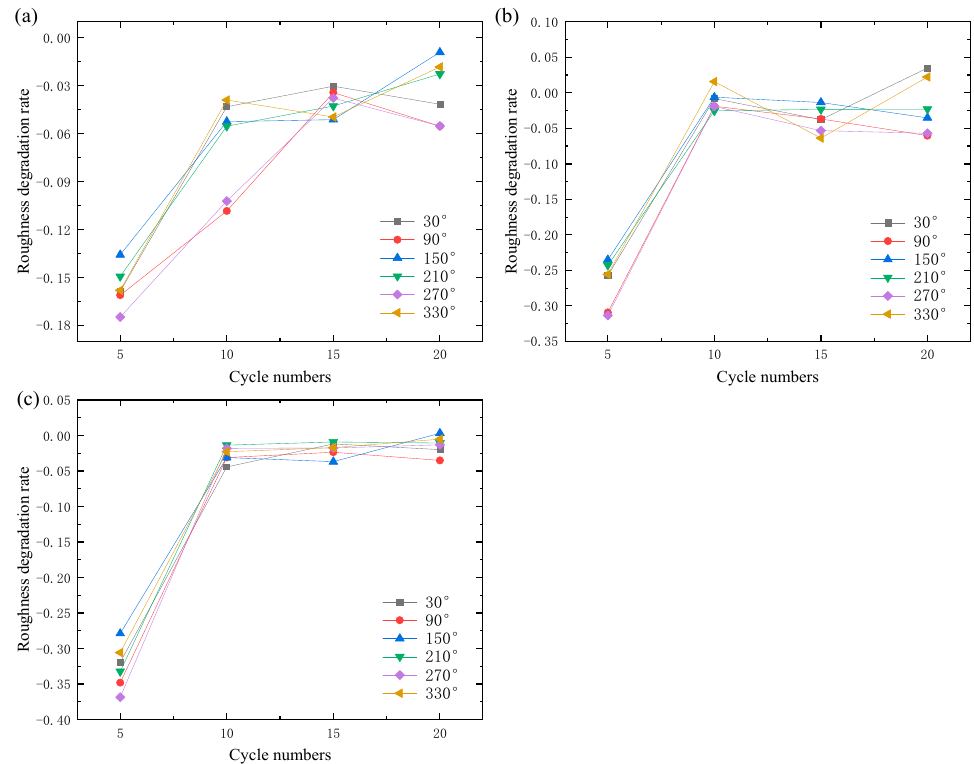
Figure 10. Plots of the roughness parameter, 𝐴 (cid:2868) 𝜃 (cid:3040)(cid:3028)(cid:3051)∗ /(𝐶 + 1) , degradation rate of the lower joint surface under different normal stresses: ( a ) 0.4 MPa, ( b ) 1.0 MPa, and ( c ) 2.5 Mpa. Using the Cartesian coordinate system to plot the roughness parameter curves can more clearly and intuitively show the degradation rate otherness of the joint surface roughness under different normal stress conditions. Error! Reference source not found. a clearly shows that the roughness parameter 𝐴 (cid:2868) 𝜃 (cid:3040)(cid:3028)(cid:3051)∗ /(𝐶 + 1) decayed approximately uni- formly as the number of shear cycles increased with 0.4 MPa normal stress. The roughness